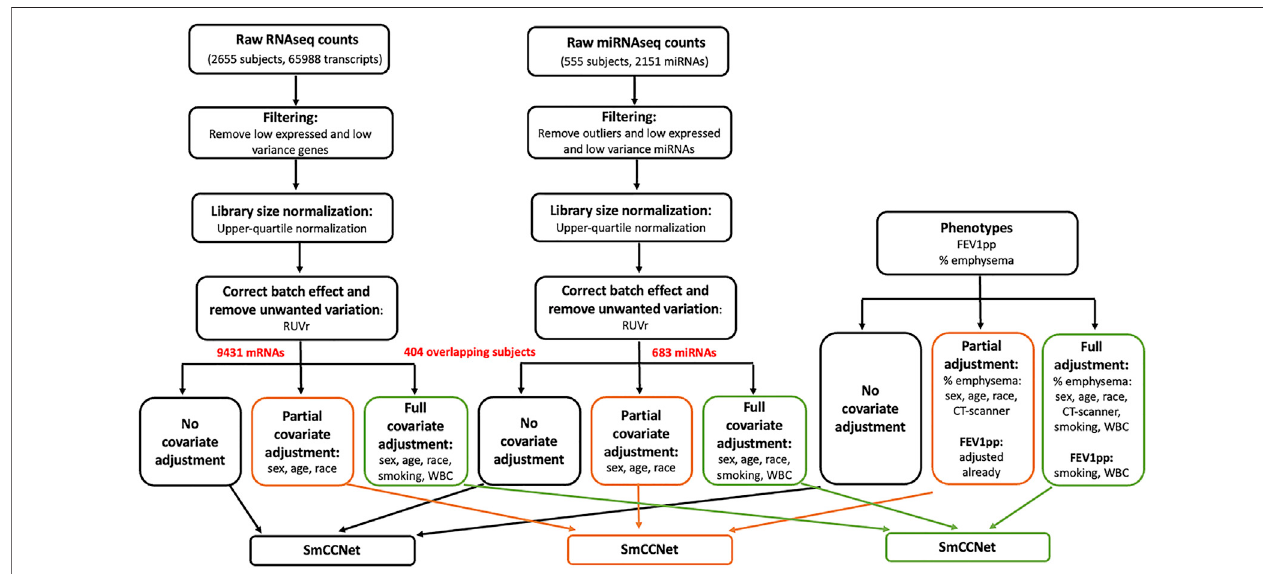
FIGURE 1 | Flowchart of data preprocessing and covariate adjustment for SmCCNet analysis. The miRNA ( n (cid:1) 555) and mRNA ( n (cid:1) 2655) high-throughput sequencing data were from peripheral blood samples collected at COPDgene phase II study. For RNAseq gene count data, the low-expressed and low-variance genes wereremoved.Speci fi cally,we fi rst fi ltereddowntoproteincodinggenes.Thenforeachgene,werequiredmorethan10readsinatleast500samples,andthestandard deviation to be greater than 30. The upper-quartile normalization and RUVr (remove unwanted variation using residuals) methods were applied to normalize the library size, correct batch effect and remove unwanted variation. The resultant data were either preserved or further adjusted with two different sets of covariates [partial adjustment: sex, age and race; full adjustment: sex, age, race, current smoking status and white blood cell (WBC) percentages]. The miRNA expression count was processedsimilarlytothegenecountdata;151samplesofmiRNAdatawereremovedduetolowsequencingdepth,missingclinicalphenotypes,orbeinginabadbatch (see detail in Methods). After removing three outlier miRNAs with large counts (individual reads > 5 million), we fi ltered out “ absent ” and low-variant miRNAs by requiring more than 10 reads in at least 200 subjects, as well as a minimum standard deviation of 10 across subjects. The clinical phenotypes including FEV 1 pp and % emphysema were processed and adjusted correspondingly to match mRNA and miRNA data ( n (cid:1) 404) for the downstream SmCCNet analysis. Of note, FEV 1 pp is already adjusted for sex, age, and race. Thus, no additional adjustment was needed in the partial adjustment. In addition, CT scanner model is a potential cofounder for percent emphysema, and it was included in the partial and full adjustment for percent